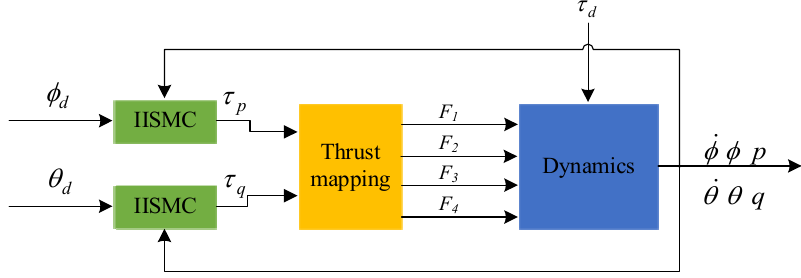
Figure 6. The improved integral sliding mode control ‐ based attitude ‐ control.